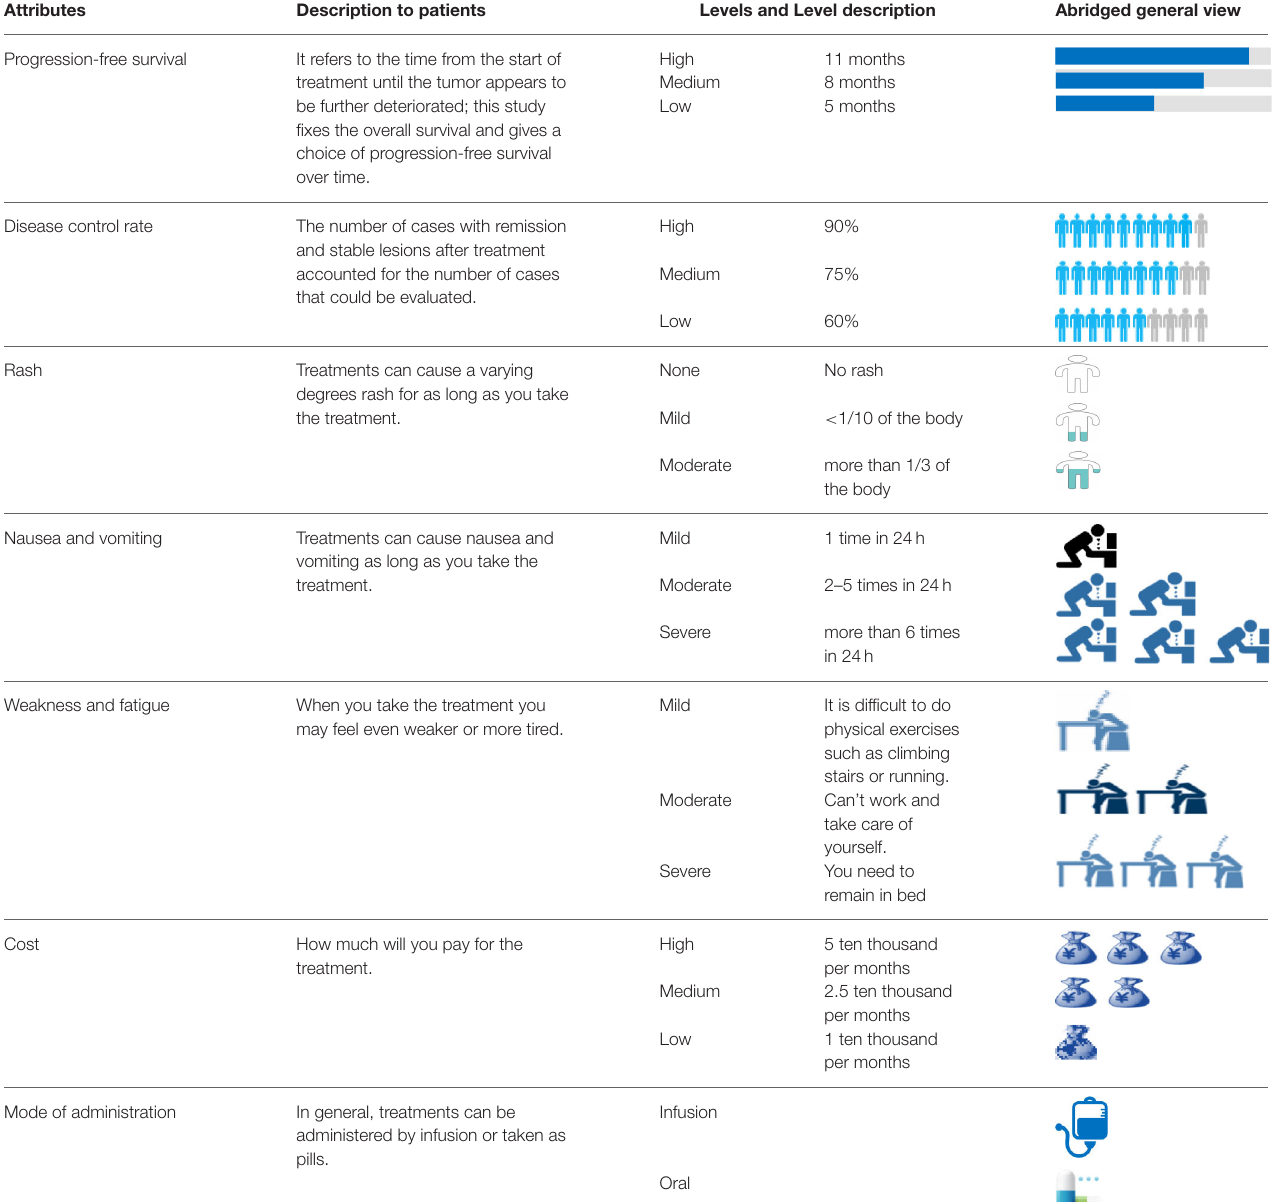
TABLE 1 | Attributes and levels for the choice tasks. Attributes Description to patients Progression-free survival